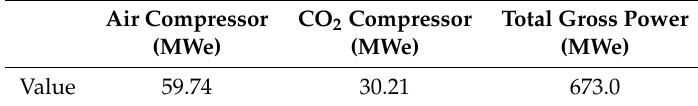
Table 2. Case B1B plant performance.